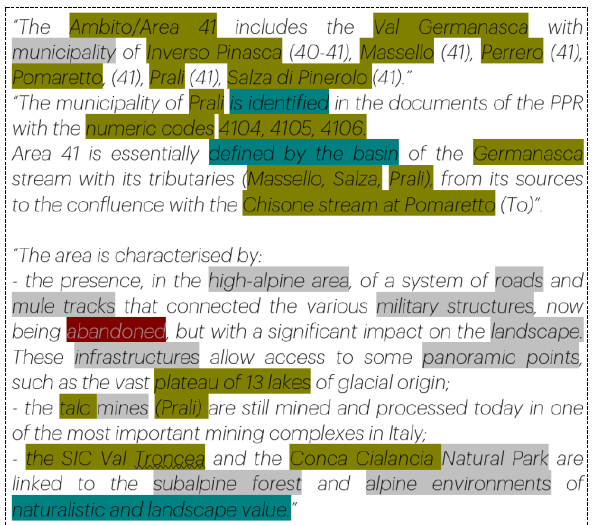
Figure 4. Concepts, relations and properties from PPT documents.